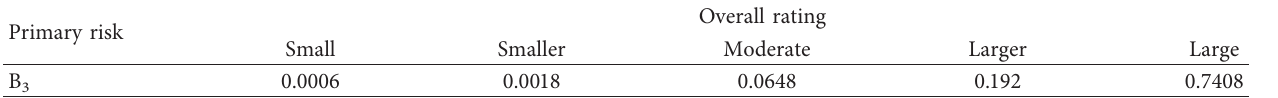
Table 8: Probability distribution of risk level B3 for the main risk at the guideline level.